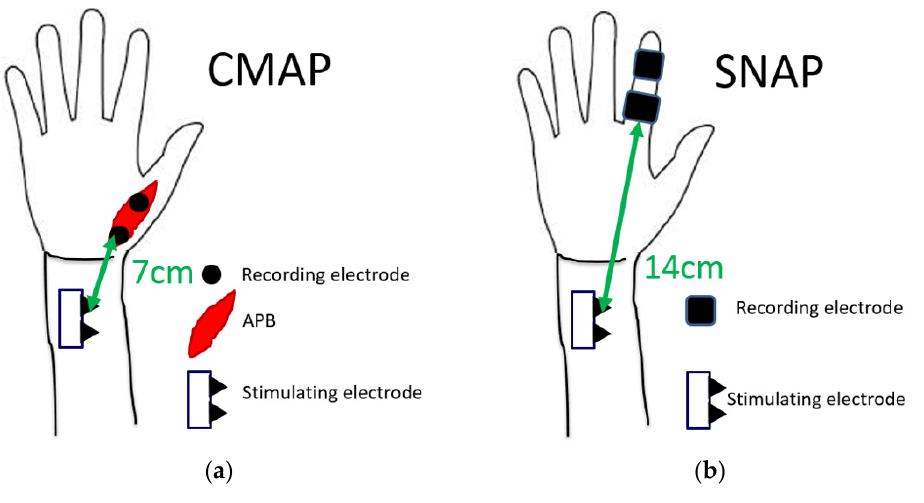
Figure 2. Measurement conditions of latencies of ( a ) CMAP and ( b ) SNAP.